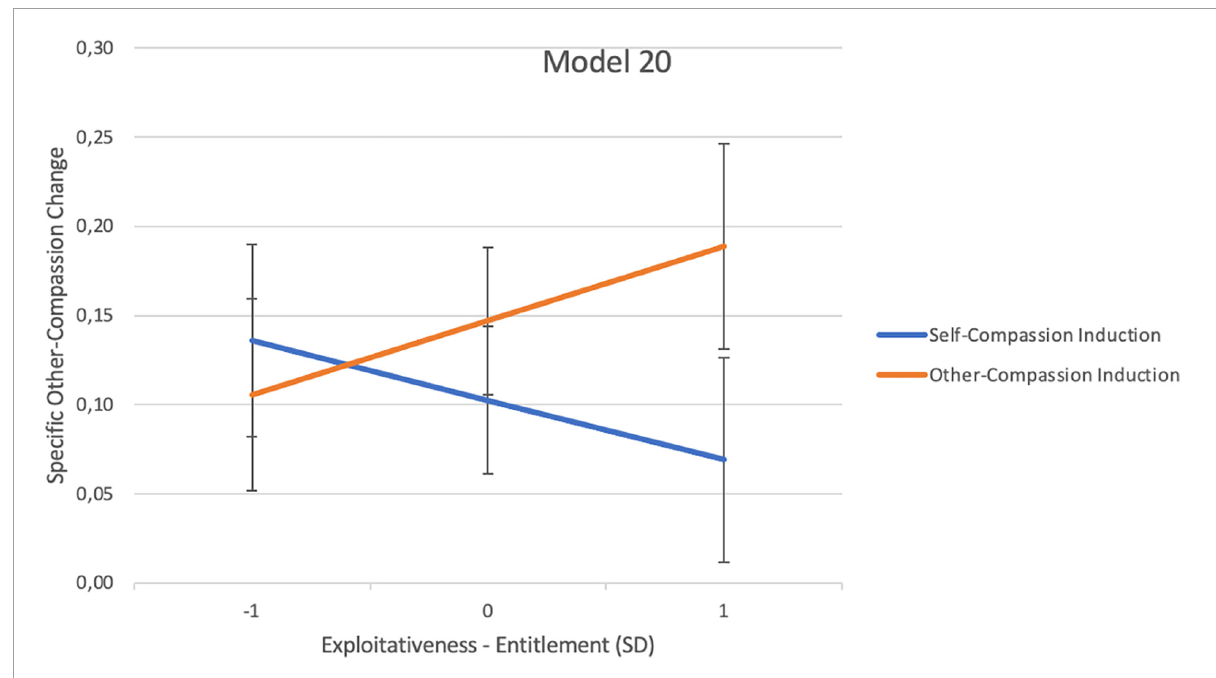
FIGURE2 Moderation regression interaction plot; displaying the average specific other-compassion change scores for pick-a-point values (SD) of grandiose exploitativeness-entitlement traits for each induction type. The y -axis represents the pre-to-post induction specific OC change scores. Change scores of zero indicate no improvement or worsening. The higher the value on the y -axis, the larger the improvement. The error bars represent the standard error.